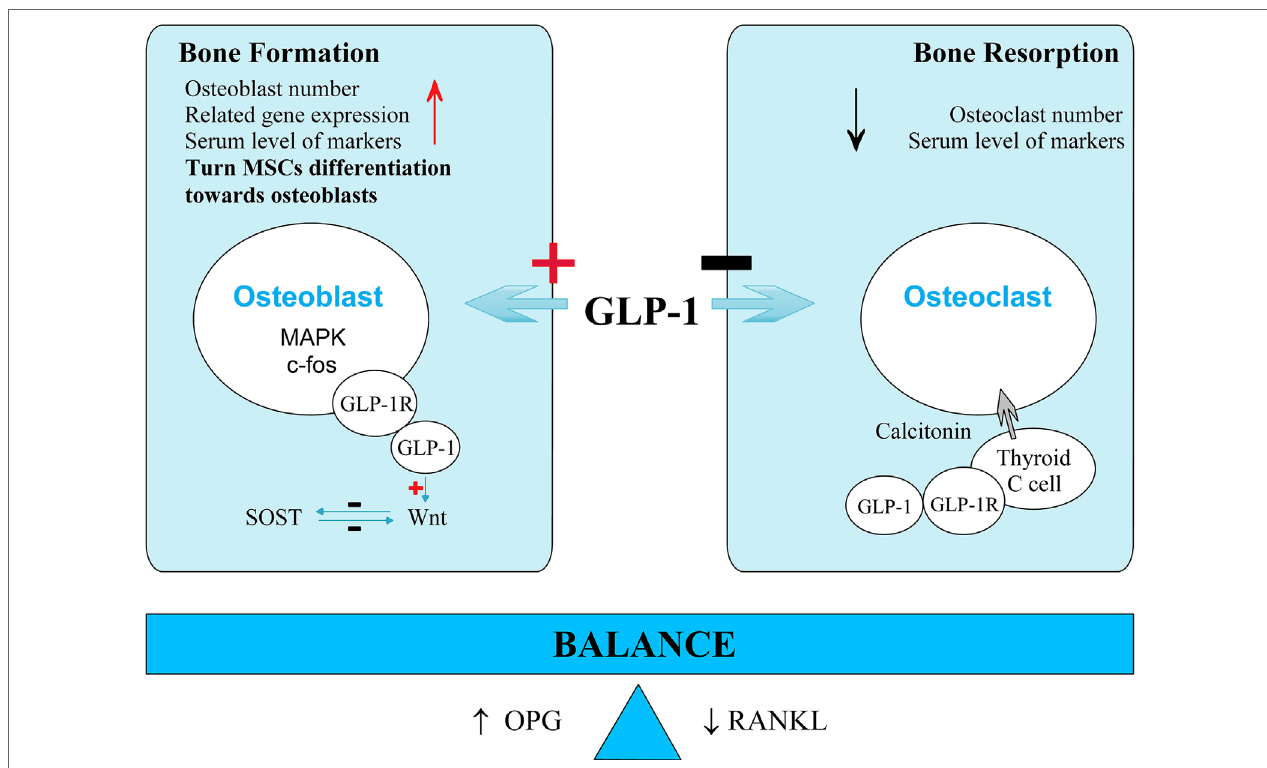
FiGURe 1 | Potential mechanism of glucagon-like peptide-1 (GLP-1) on bone metabolism . GLP-1 promotes bone formation and inhibits bone resorption. For bone formation, GLP-1 results in increasing osteoblast number, gene expression related to bone formation and serum level of bone formation markers. GLP-1 might bind to its receptor on osteoblast and its function is possibly mediated by mitogen-activated protein kinase (MAPK) pathways, Wnt pathways, or c-fos transcription promotion. GLP-1 also turns mesenchymal stem cell (MSC) differentiation from adipocytes toward osteoblasts. For bone resorption, GLP-1 also results in decreasing osteoclast number and serum level of bone resorption markers. But GLP-1 might act through a calcitonin-dependent way in thyroid C cells. Furthermore, GLP-1 increases OPG expression while decreases receptor activator for nuclear factor- κ B ligand (RANKL) expression. GLP-1 helps to maintain the balance between bone formation and bone